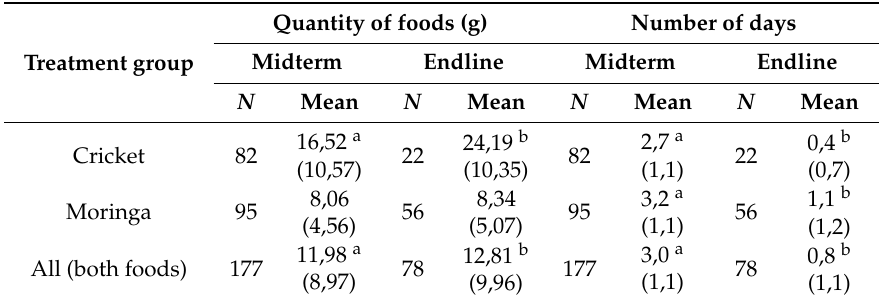
Table 3. Mean ( ± SD) daily quantity of foods (g) and mean number of days of complementary food consumption among treatment groups at midterm and baseline as measured over a 3-day period